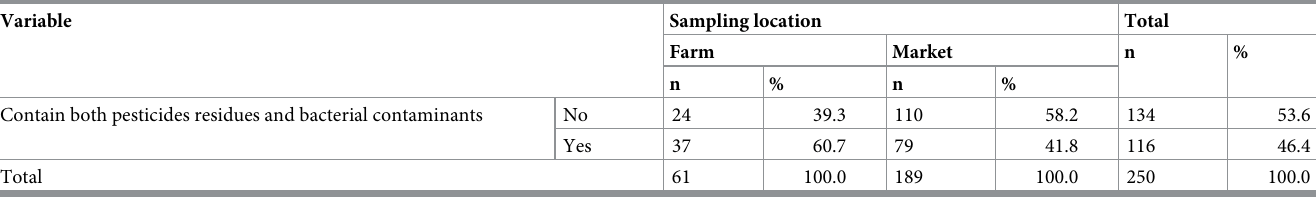
Table 8. Co-occurrence of pesticides residues and bacterial contaminants. Variable